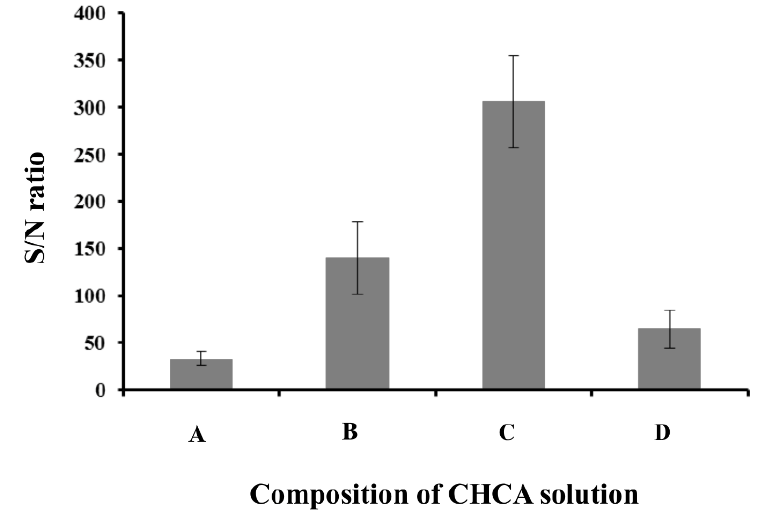
Figure 2. Effect of CHCA solution composition on the S/N ratio of posaconazole. CHCA solution in 0.1% aqueous TFA contained ( A ) 30% acetonitrile, ( B ) 30% methanol, ( C ) 50% methanol, and ( D ) 70% methanol. Experimental conditions: sample volume, 3 µ L; CHCA solution volume, 3 µ L; and posaconazole concentration, 1.00 µ M. A total of 200 pulsed laser shots were applied using a laser adjusted to energy levels that slightly exceeded the threshold.